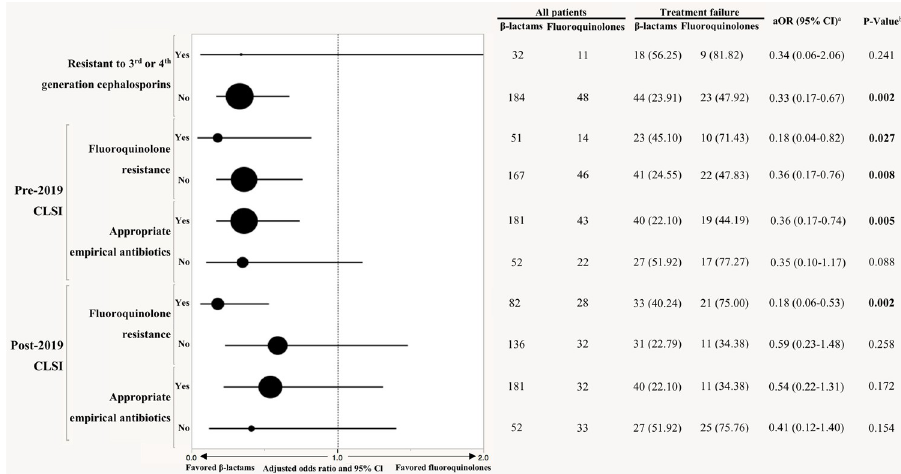
Fig 2. Forest plot of treatment failure by resistance patterns. Data were presented as N (%). The fluoroquinolones group was the reference group. The horizontal lines running through the dots represented the 95% CIs. The size of the dot for each aOR in the plot is proportional to the number of patients. UTI: Urinary tract infection; CCI: Charlson comorbidity index; Clcr: Creatinine clearance; SOFA: sequential organ failure assessment; Adjusted covariates in aOR: age, AMI, temperature. P-value was calculated by multivariable logistic